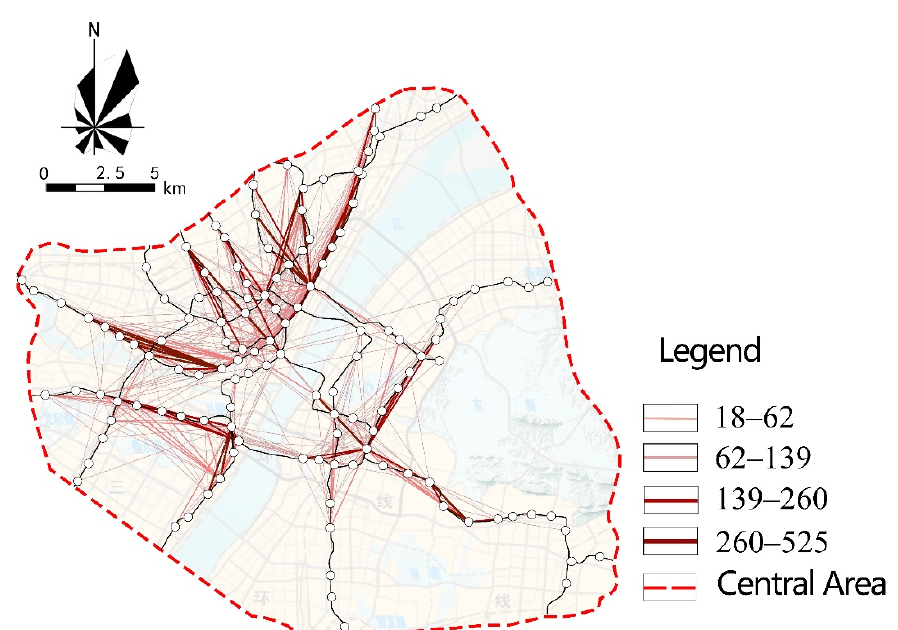
Figure 7. Distribution of rail transit school commuting direction. Table 3. Typical school commuting regional distribution.